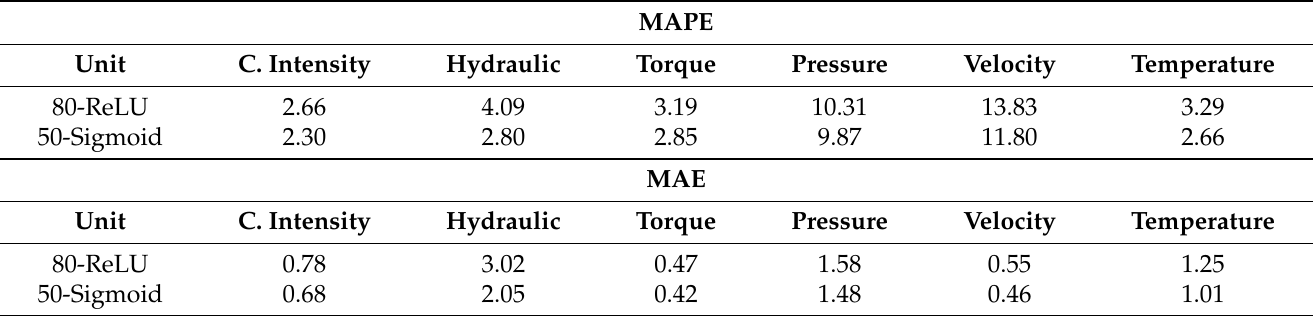
Table 5. Summary of the best results obtained with different numbers of units in the hidden layer.